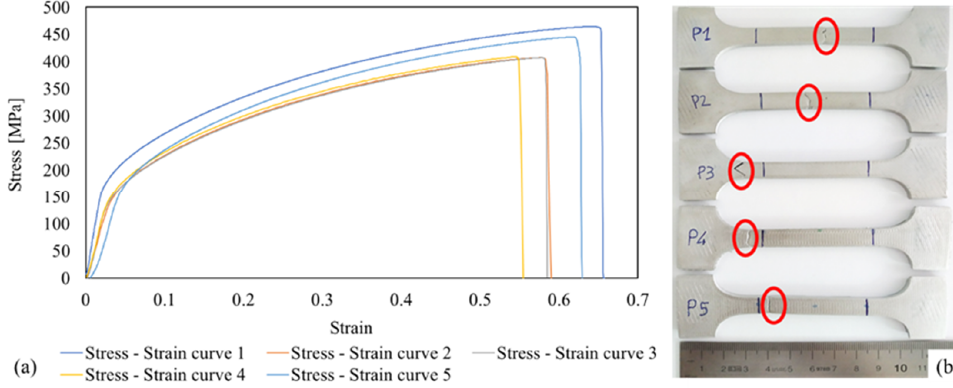
Figure 3. Tensile stress–strain curves ( a ); fracture positions of the samples ( b ).